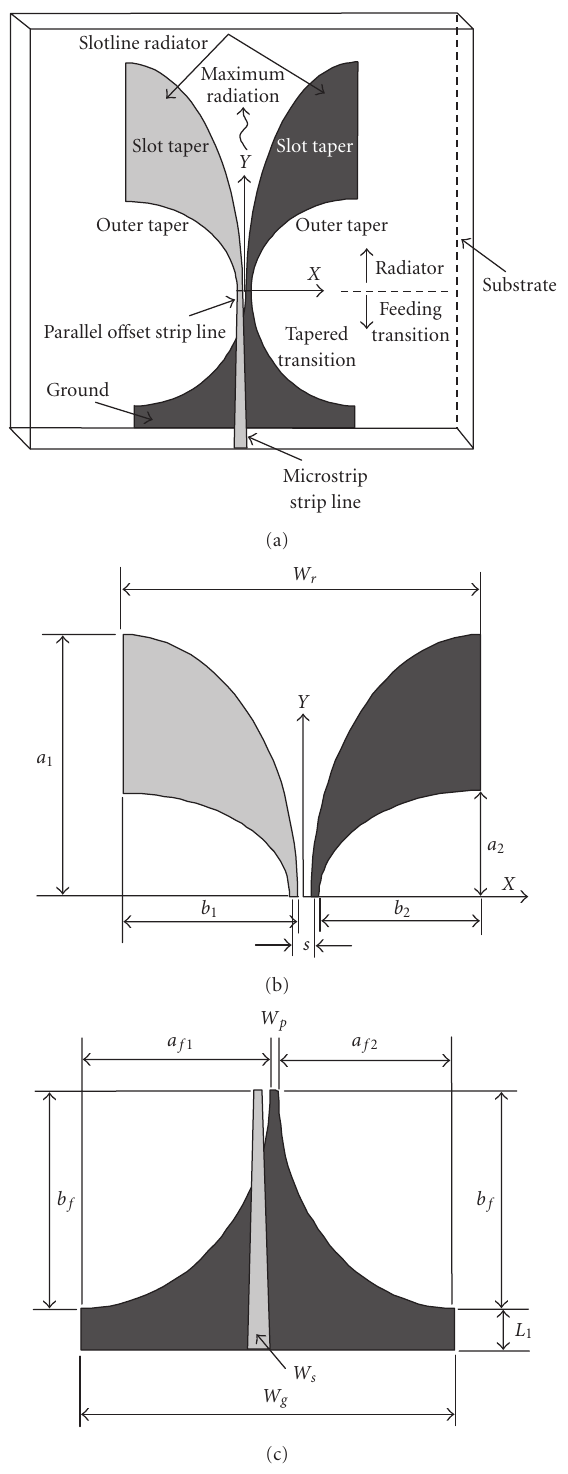
Figure 1: Geometry of a typical DETASA: (a) overall view, (b) ta- pered slotline radiator, and (c) feed line